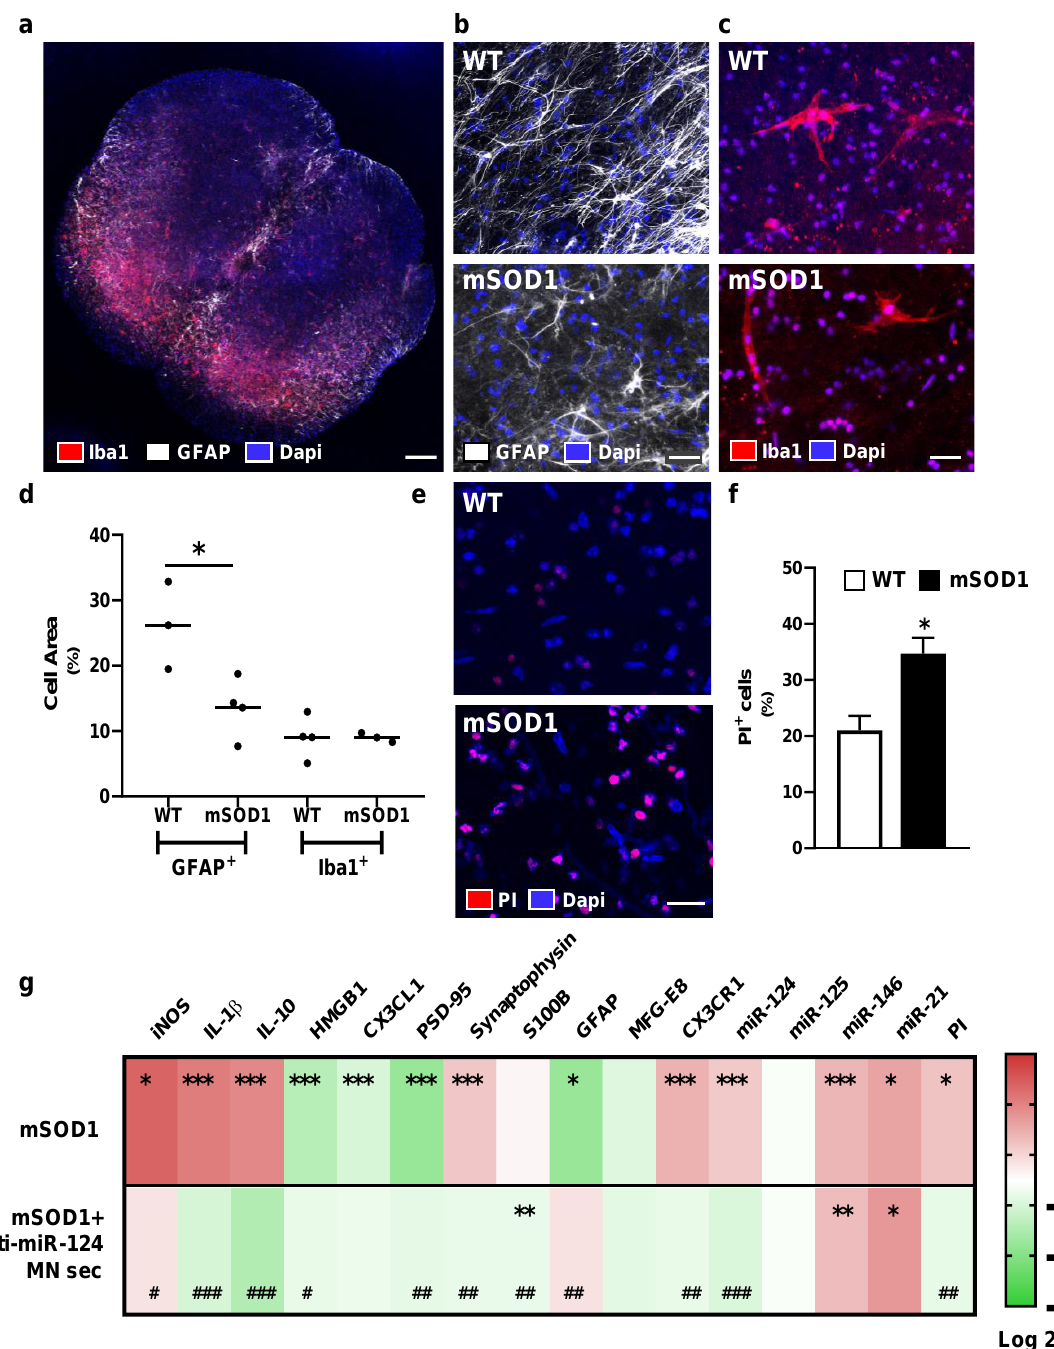
Figure 6. Spinal organotypic cultures from transgenic mSOD1 mice at early symptomatic stage show increased cell death, together with alterations in neuron–glia communication and dysregulation of inflammation-associated genes, which are suppressed by the secretome from anti-miR-124-treated mSOD1 MNs. Organotypic cultures were obtained from the spinal cord of 12-weeks old mice, either WT or TG. After 3 days in vitro, slices were incubated for additional 24 h with MN culture media. ( a ) Representative image of a transversal spinal cord slice stained for microglia and astrocytes. Nuclei are in blue (Dapi), microglia in red (Iba-1), and astrocytes in white (GFAP). Representative immunohistochemistry images for